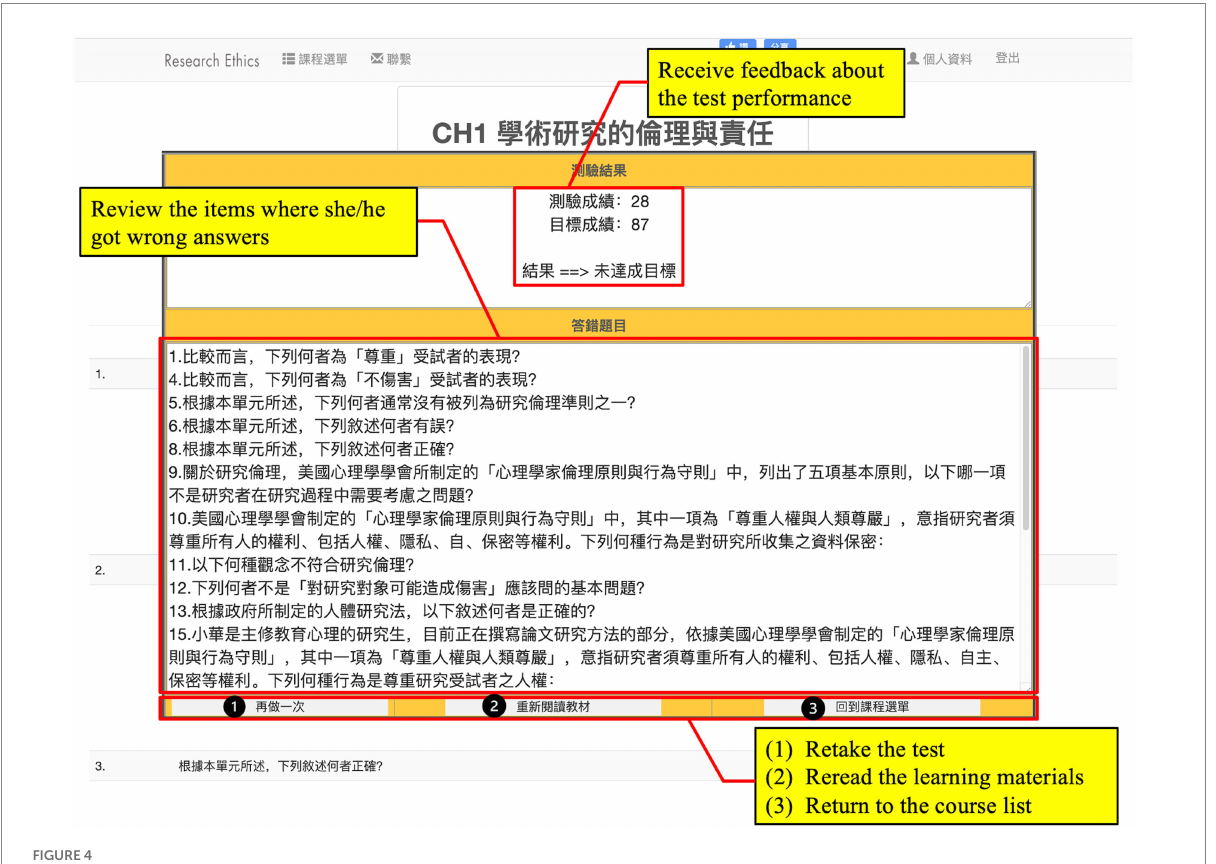
FIGURE 4 The user interface for test